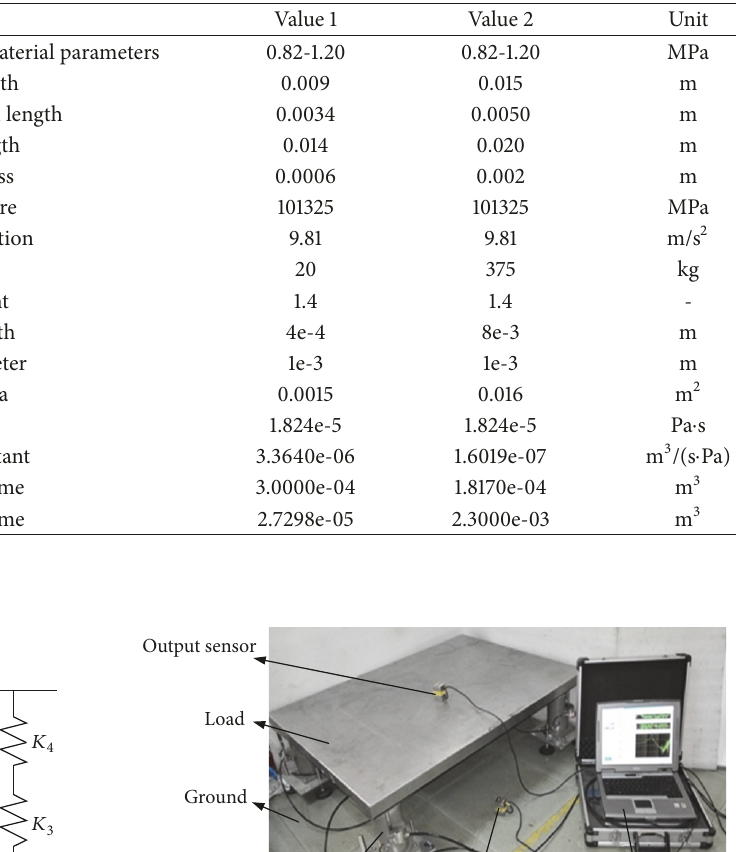
Table 2: Parameters of the dual-chamber pneumatic in the two experiments.